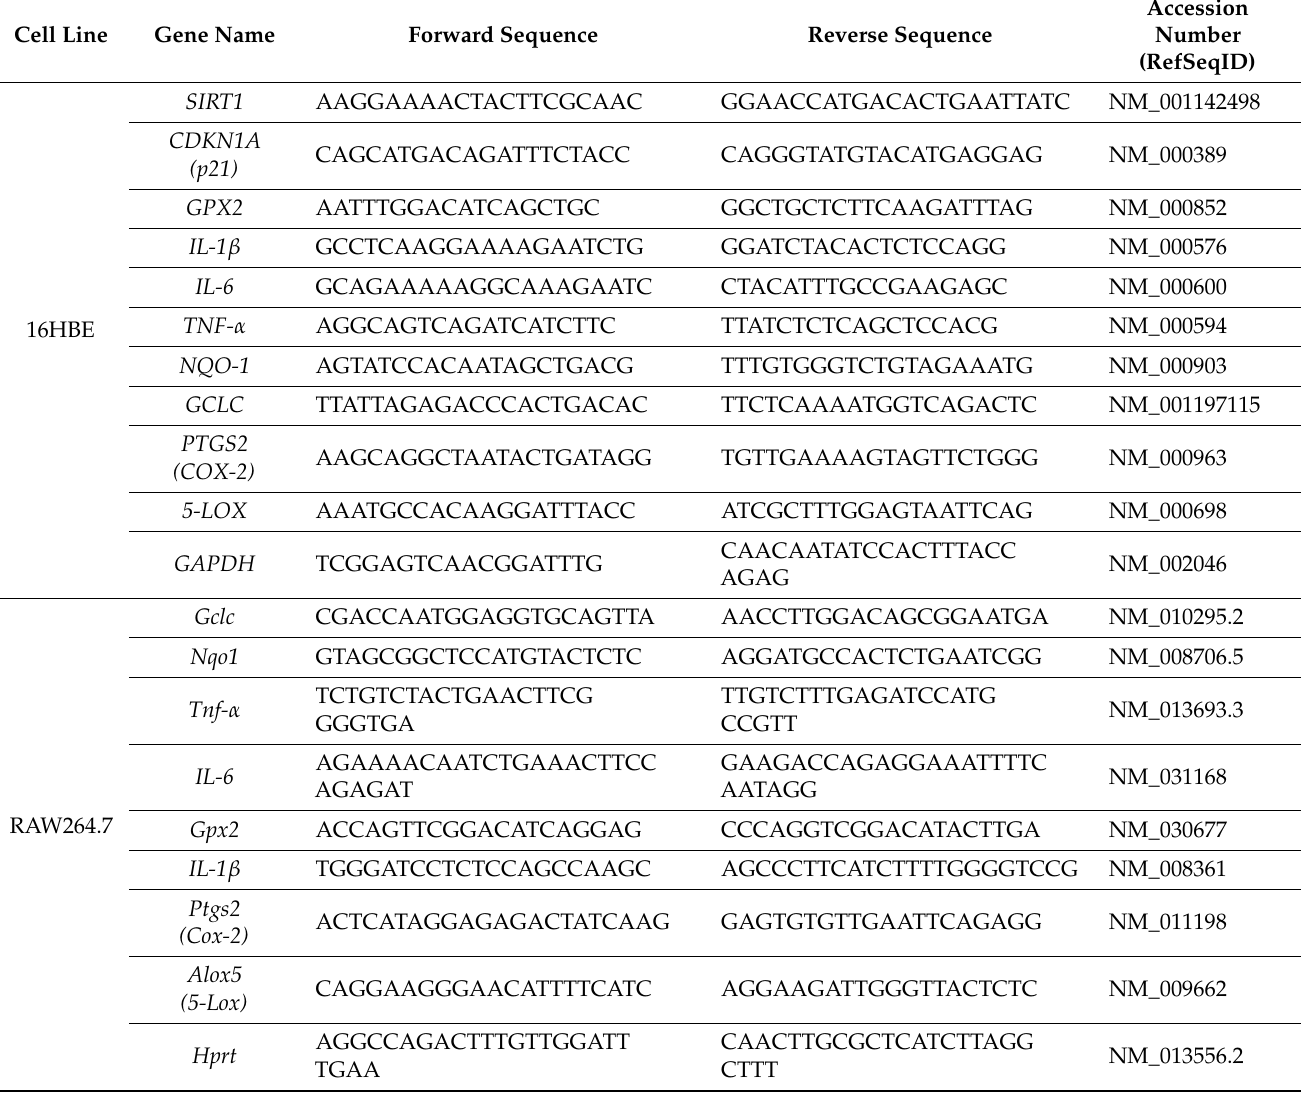
Table 1. List of primers